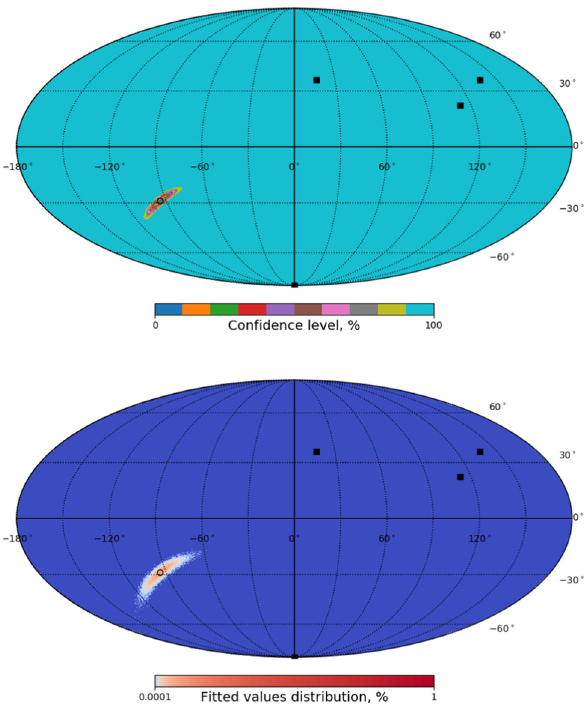
Fig. 3 Mollweide projection of confidence area in equatorial coor- dinates for a CCSN at the Galactic Centre (black dot) computed using triangulation between four detectors (black squares): IceCube, KM3NeT/ARCA,Hyper-KamiokandeandJUNO.Top:confidencearea assuming true delays, bottom: fitted positions distribution for 100,000 realisations of the delay